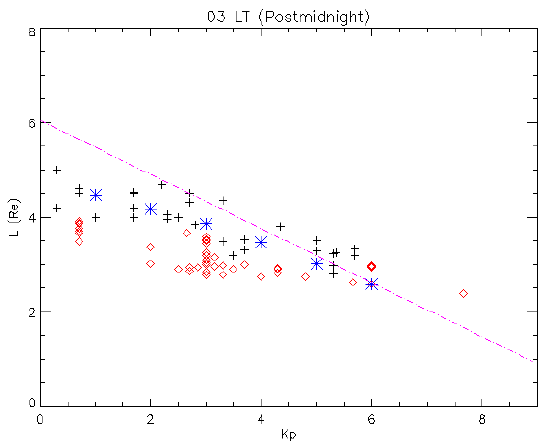
Fig. 13. Radial distance of the plasmapause observed at 03:00 MLT in the EUV observations for all 4 periods of time presented in this paper. When the K p index decreases, symbols are red diamonds ♦ ; they are black crosses (+) when K p increases. The blue stars repre- sent the plasmapause position found with the instability model for a constant value of K p . The pink line corresponds to the linear rela- tion found by Moldwin et al. (2002) between L and K p for average plasmapause crossings observed by CRRES in the dawn LT sector between August 1990 and October